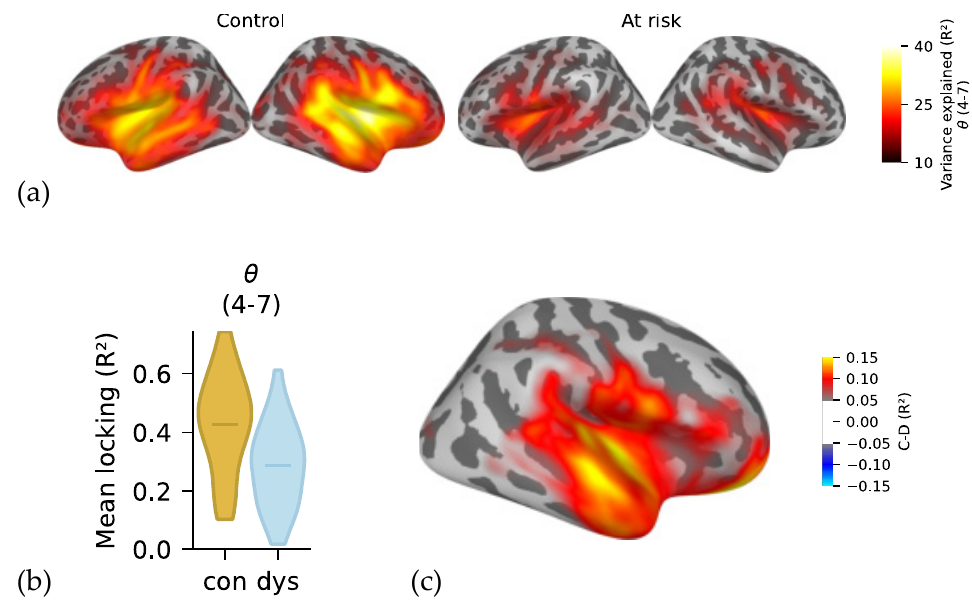
Figure 3. ( a ) GA maps in source space for theta (4–7 Hz) in control and at-risk infants collapsed across 6 and 12 months. ( b ) Violin plots show larger stimulus locking at theta for control than for at-risk infants ( p < 0.001). ( c ) Group effect plotted on the brain surface (control infants minus at-risk infants).